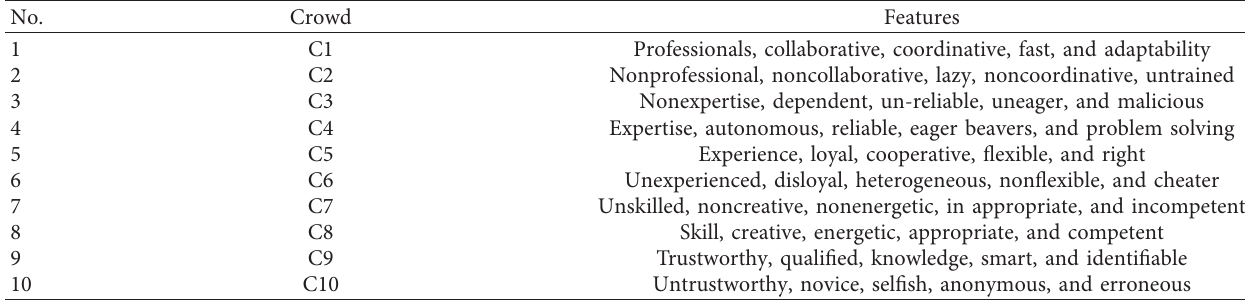
Table 1: Representation of the crowd worker set.